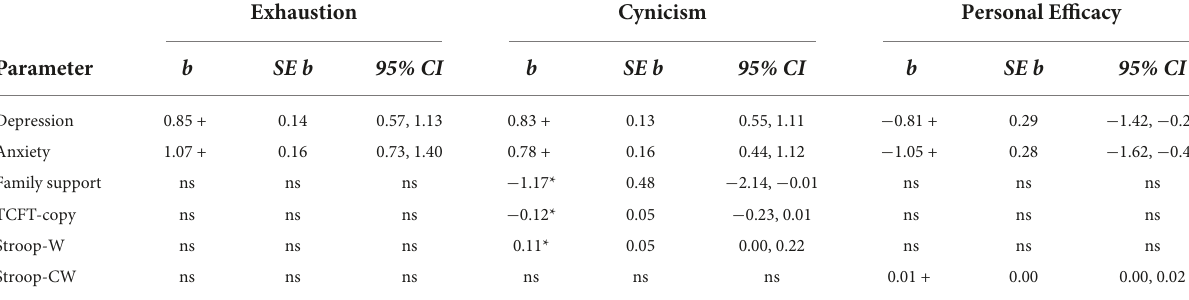
TABLE 3 Linear mixed model analysis of MBI-GS subscales as predictive factors ( N = 104). Exhaustion Cynicism Personal Efficacy